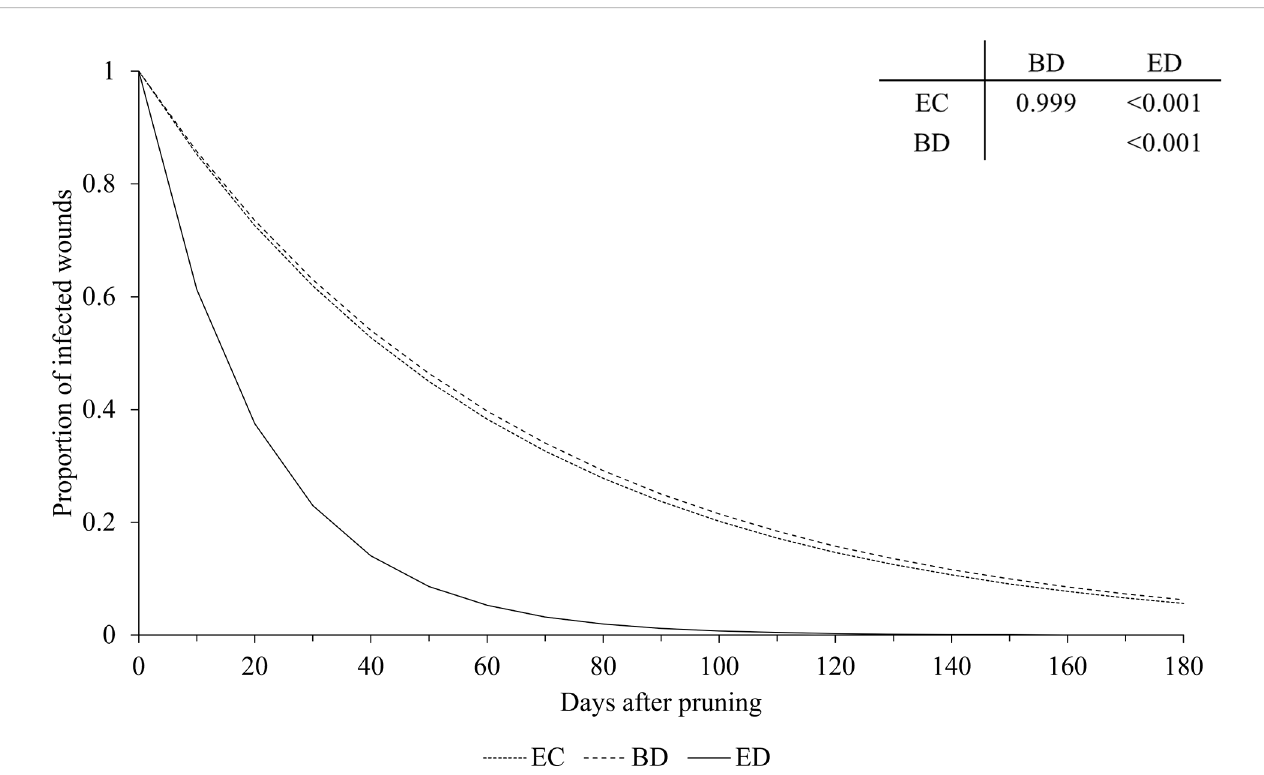
FIGURE 6 Effect of GTDs on the relationship between the proportion of pruning wounds that became infected (Y axis) and the time after pruning (DAP) when the wounds were arti fi cially inoculated with GTD fungi (X axis). Esca complex (EC - dotted line), Botryosphaeria dieback (BD - dashed line), and Eutypa dieback (ED - full line). Lines were predicted by equation [1] (see text). The table shows the P values for the differences between estimates of parameter a of equation [1] (see Table 2 for estimates of a for the